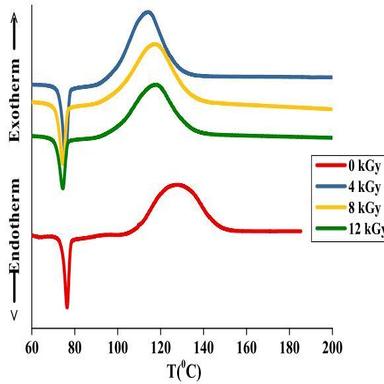
DSC scans of the unexposed and exposed samples of STS ChGA.